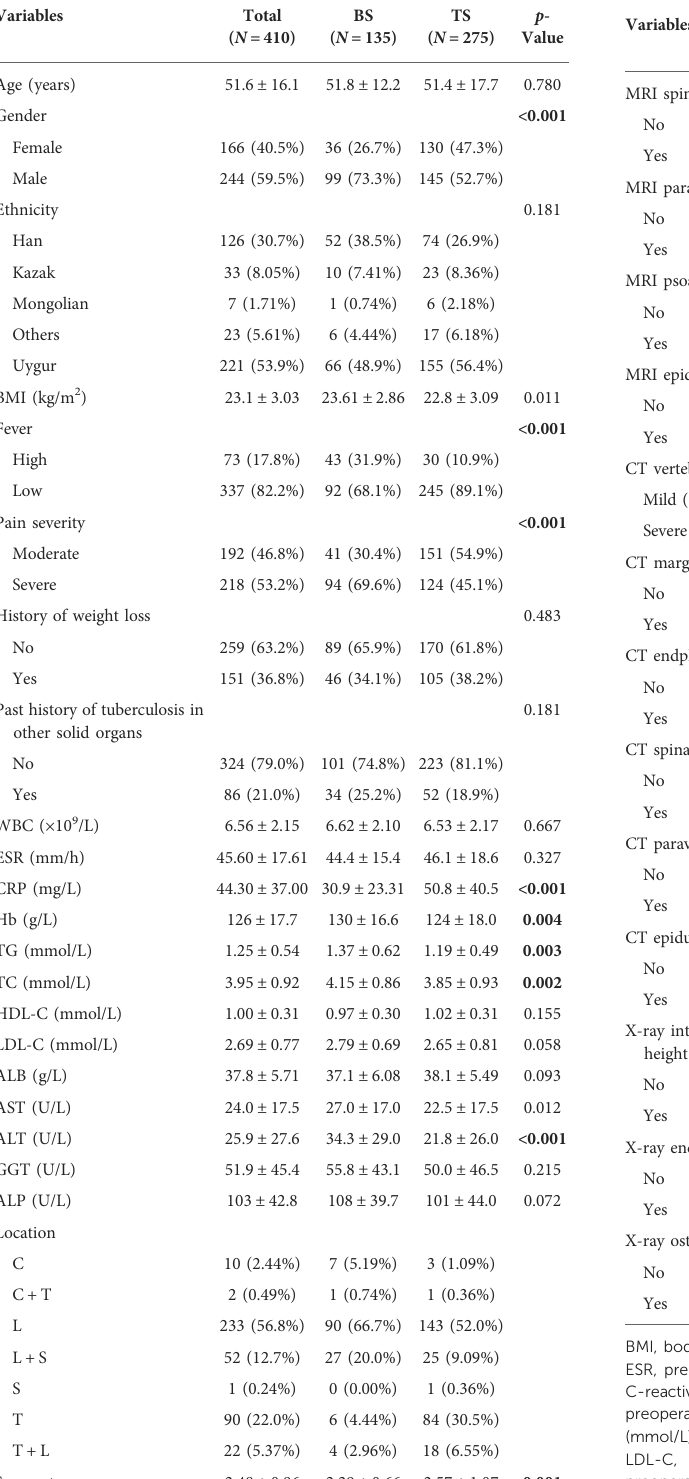
TABLE 1 Baseline characteristics of